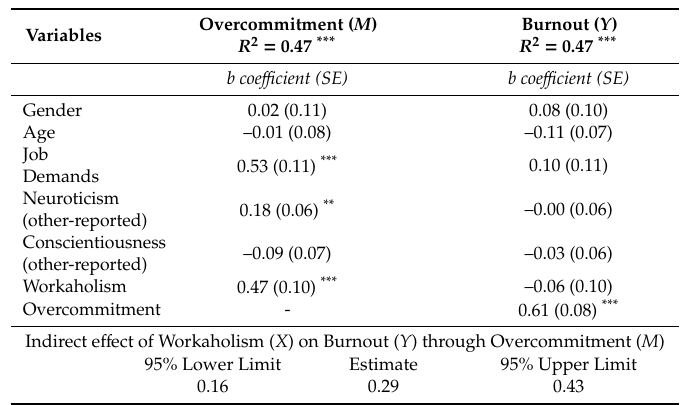
Table 2. Results of Mediation